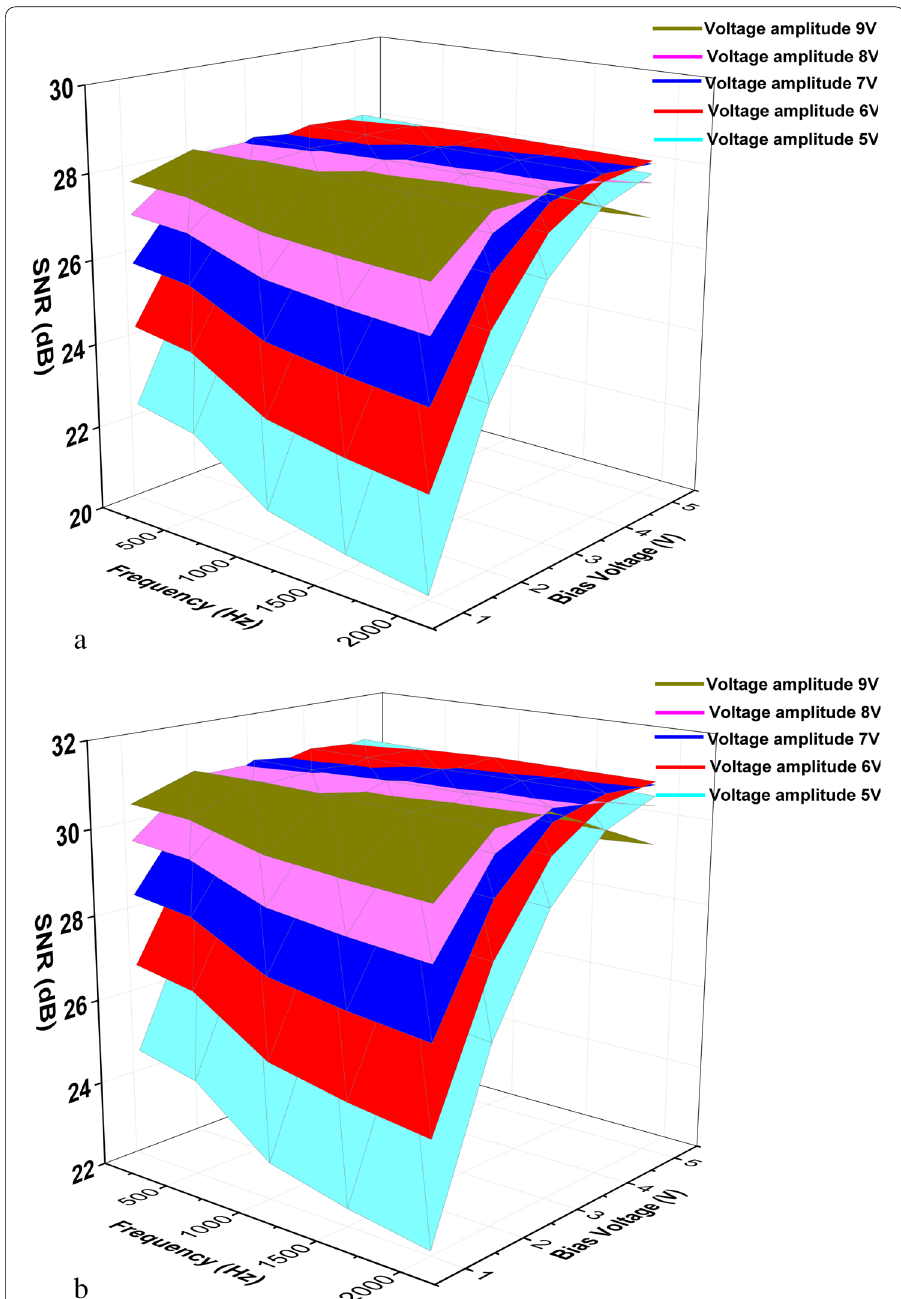
Fig. 12 a Calculated SNR of the mixed white LED source with frequency, bias voltage and voltage amplitude. b Measured SNR of the mixed white LED source with frequency, bias voltage and voltage